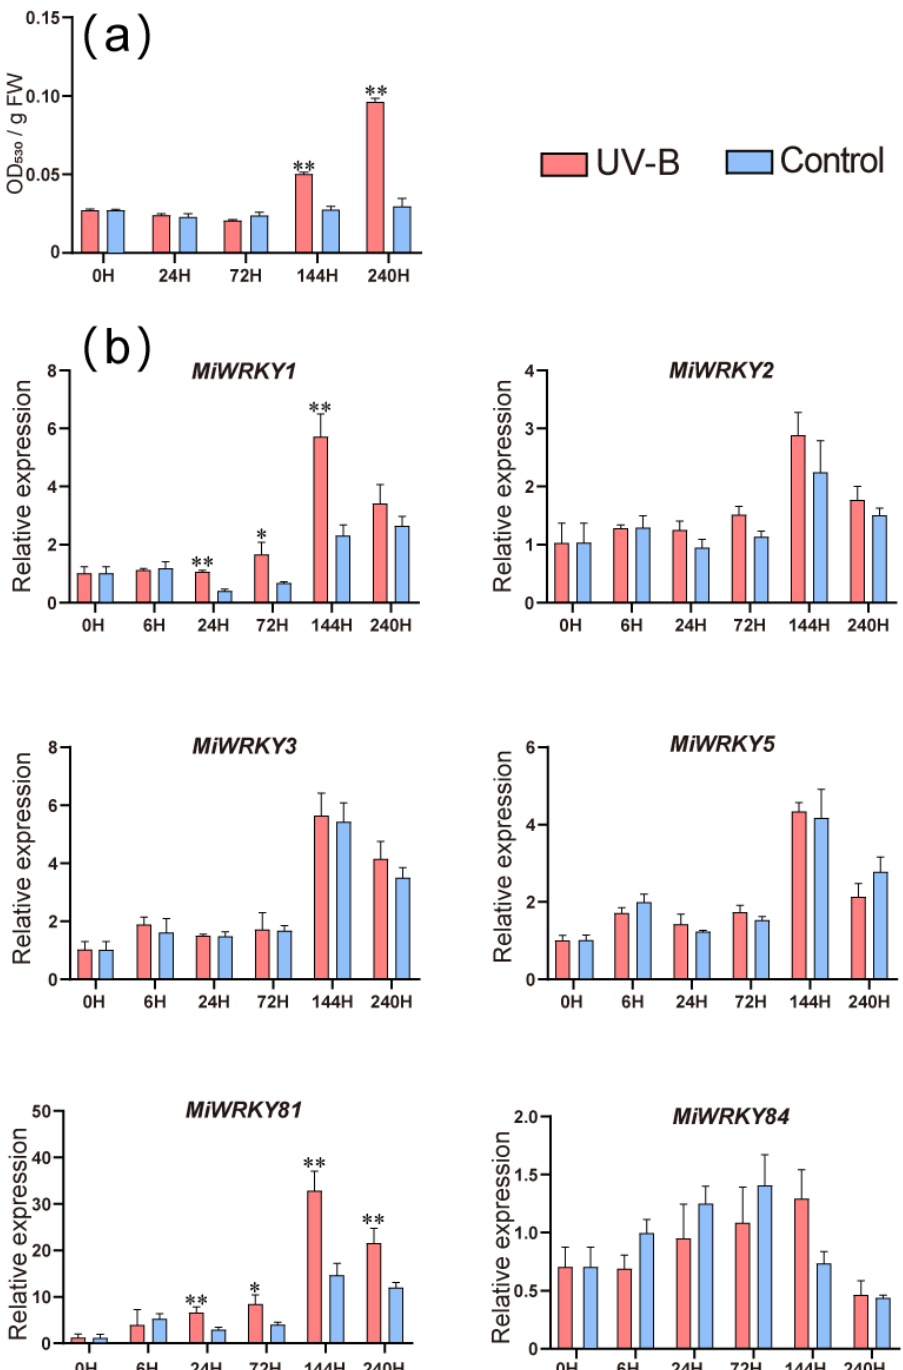
Figure 8. ( a ) The contents of anthocyanin in UV-B/visible light-treated and control (darkness) ‘Hongmang NO.6′ mango peel. ( b ) Analysis of WRKY genes expression in UV-B/visible-light-treated and control (darkness) ‘Hongmang No. 6′ mango peel. The data represent the mean ± standard deviation with n = 3. * represents significant difference ( p -value < 0.05); ** represents highly significant difference ( p -value < 0.01), as analyzed by Student’s t -test.